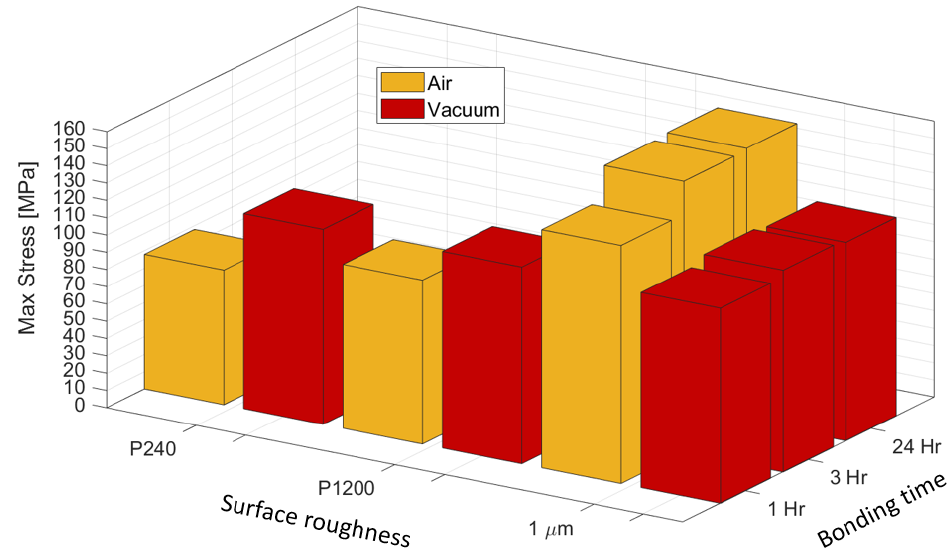
Figure 23. Summary of the bond strength as a function of time of DB treatment and surface rough- ness.